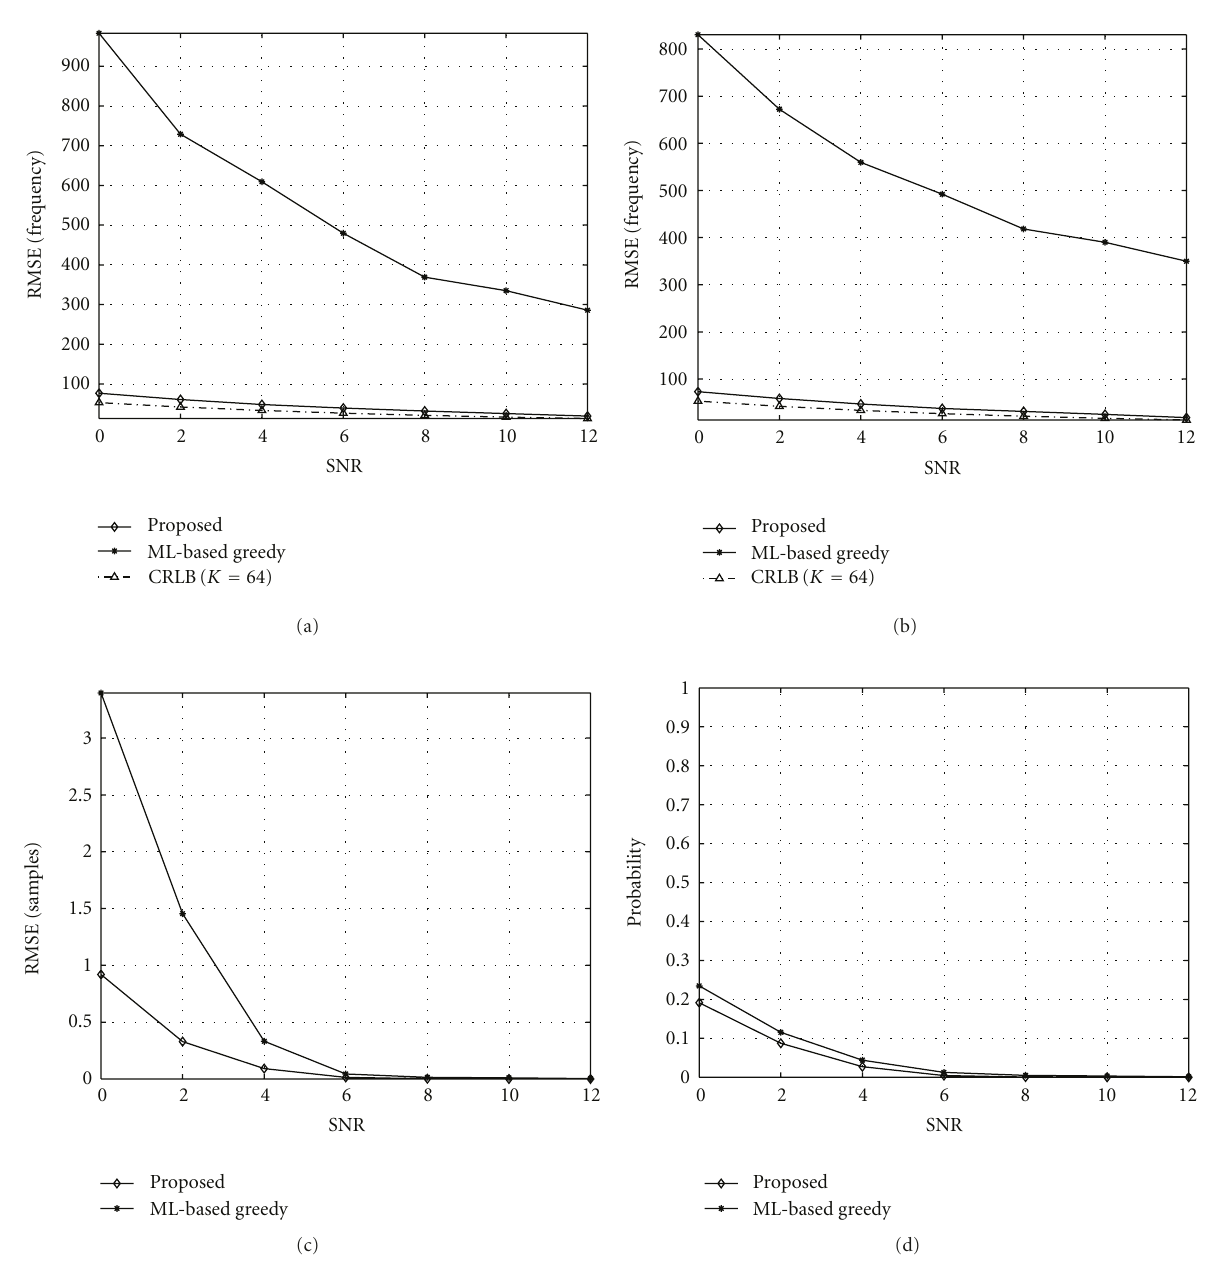
Figure 6: Root mean square estimation error versus SNR with K = random . (a) RMSE of f 1 estimate, (b) RMSE of f 2 estimate, (c) RMSE of K estimate, and (d) error probability of K